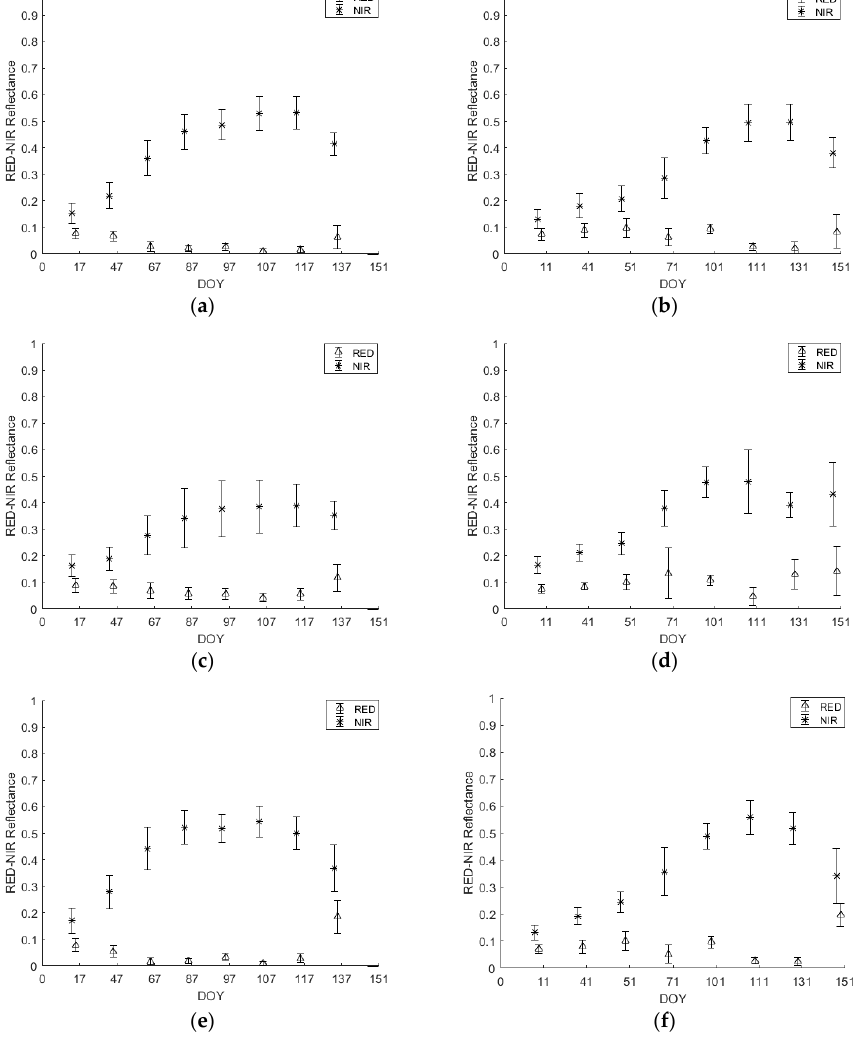
Figure 5. Mean ± standard deviation of  RED and  NIR temporal profiles of Wheat ( a ) 2016 and ( b ) ± standard deviation of ρ RED and ρ NIR temporal profiles of Wheat ( a ) 2016 and ( b ) 2017; Barley ( c ) 2016 and ( d ) 2017 and Triticale ( e ) 2016 and ( f ) 2017. Figure 5. Mean 2017; Barley ( c ) 2016 and ( d ) 2017 and Triticale ( e ) 2016 and ( f )